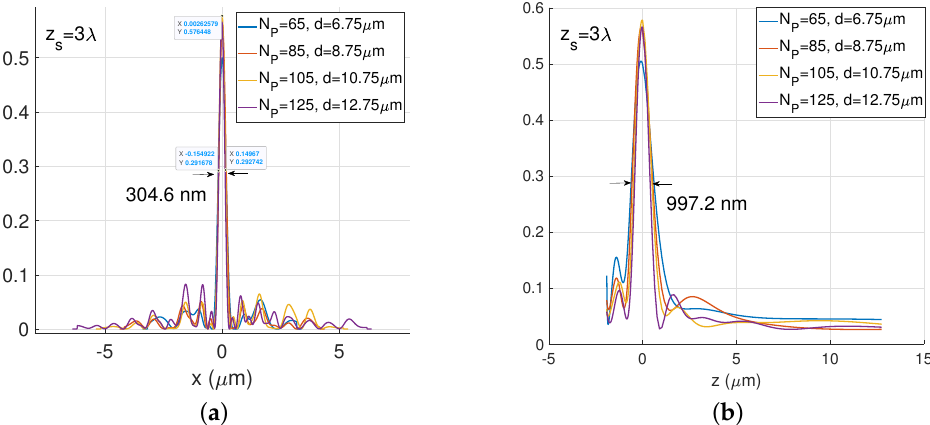
Figure 10. Design of d -wide gold plasmonic metalens consisting of N p gold nanoridges and nanoslits focusing a normal incident TM-polarized plane wave at a wavelength λ = 0.637 µ m at a distance of 3 λ . Line scans of the normalized magnetic field intensity in the transverse ( z f = 0) ( a ) and in the longitudinal x = x 0 ( b ) focal plane respectively, for four values of the couple ( N p , d ) : ( N p , d ) ∈ { ( 65,6.75 µ m ) , ( 85,8.75 µ m ) , ( 105,10.75 µ m ) , ( 125,12.75 µ m ) } . Numerical parameters: λ = 0.637 µ m, h = 400 nm, TM polarization. ( a ) | H y ( x ,0 ) | 2 /